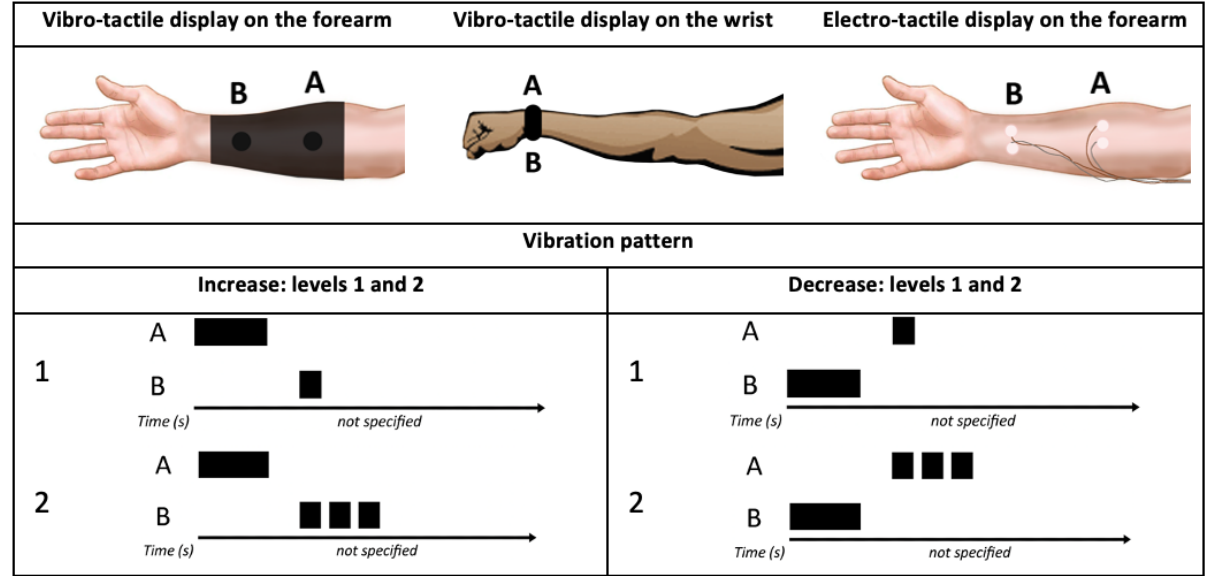
Figure 7. Three tactile displays monitoring a single variable using the same vibration/electrical stimulation pattern. The electro-tactile display on the